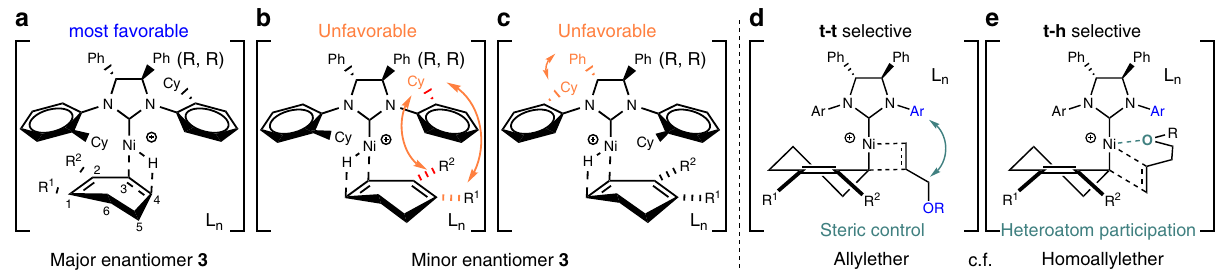
Fig. 4 Hypothetical Models for chiral insertion and regioselective insertion. a Chiral NHC – Ni(II)H insertion to diene which give major enantiomer 3. b , c Unfavorable steric interactions among NHC and diene which disfavored the insertion. d Steric control regioselective insertion of terminal ole fi n. e Role of heteroatom in regioselective insertion of homoallylether.